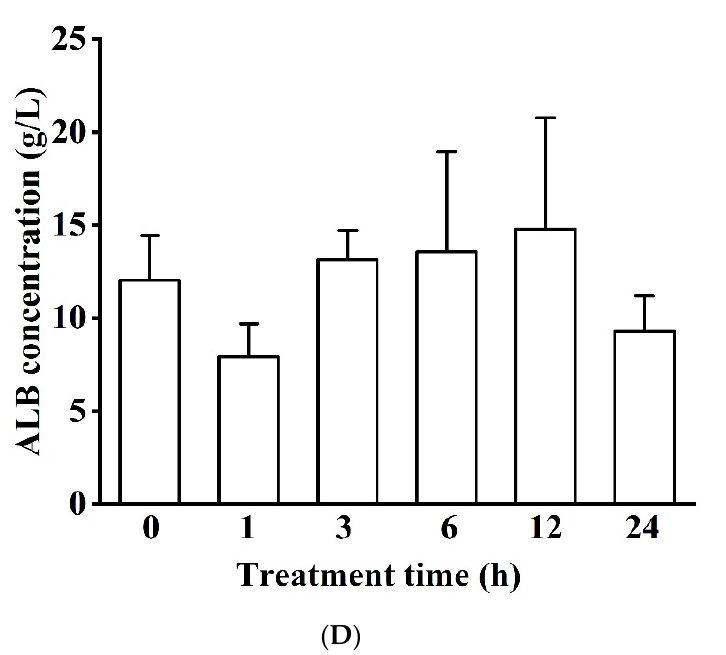
Figure 3. Effects of acute hypoxia on concentrations of glucose (GLU) ( A ), total cholesterol (TC) ( B ), triglyceride (TG) ( C ), and albumin (ALB) ( D ) in blood serum. Different letters indicate significant differences ( p < 0.05). There was no significant difference in ALB concentration among the six treatment groups.